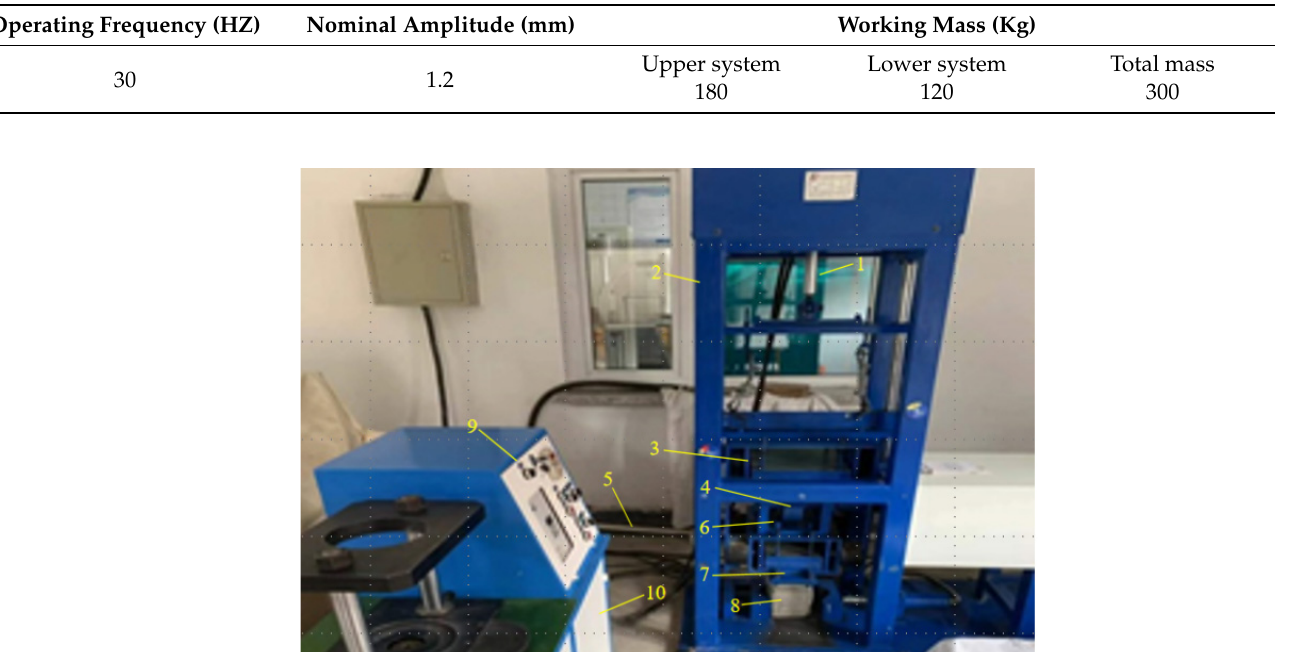
Table 4. Parameter Settings of Vibration Compactor.